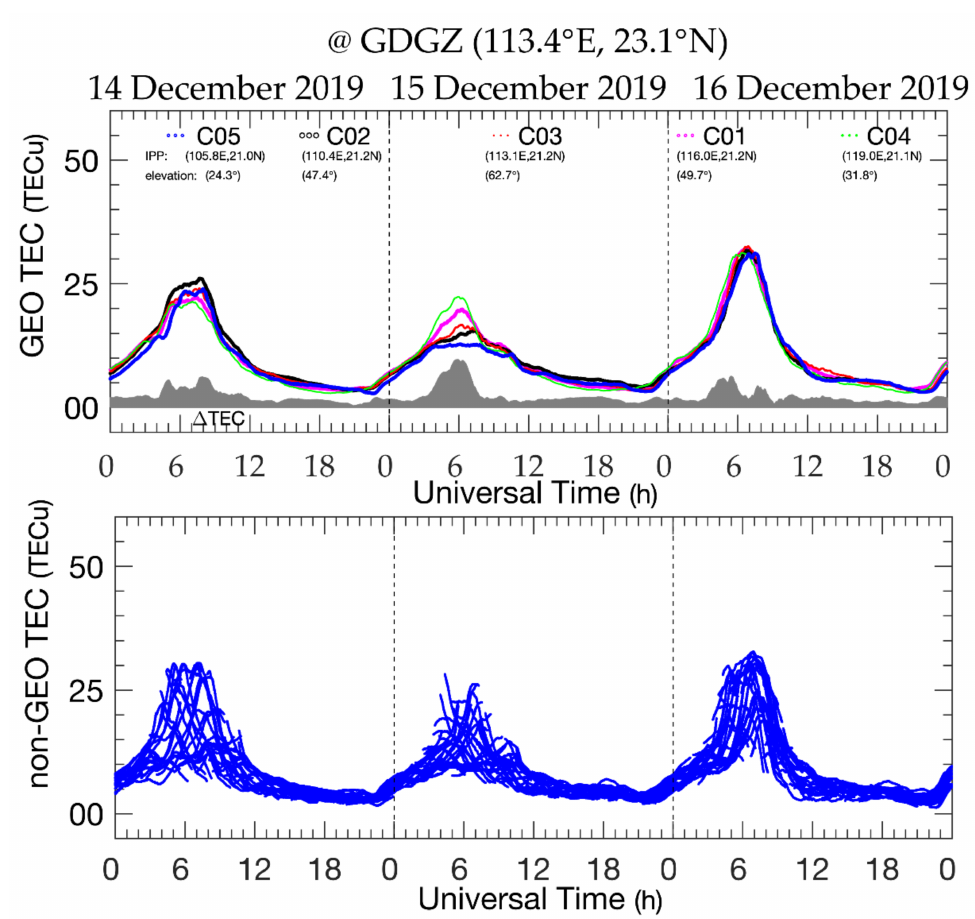
Figure 1. Temporal evolution of the TEC observations from the GNSS receiver GDGZ (113.4 ◦ E, 23.1 ◦ N) on 14–16 December 2019 (day of year (DOY) 348–350). The bottom panel plots the non-GEO TEC. The top panel is for the GEO observations. The TEC of the five GEO PRNs, along with their elevation angles and IPPs coordinates, are labelled. Gray shaded area plots ∆ TEC, the peak difference of the GEO TECs covering longitudes from 105.8 ◦ E to 119.0 ◦